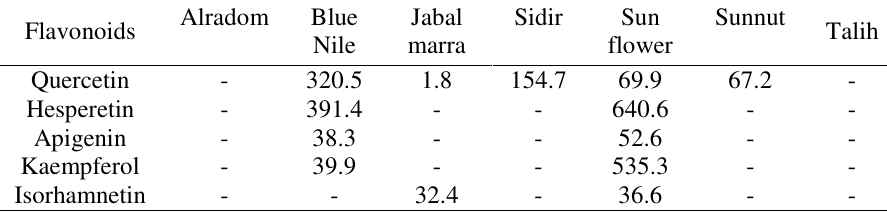
Table 6. Summary of the concentration of some flavonoids (µg/100 g) calculated in the studied honey